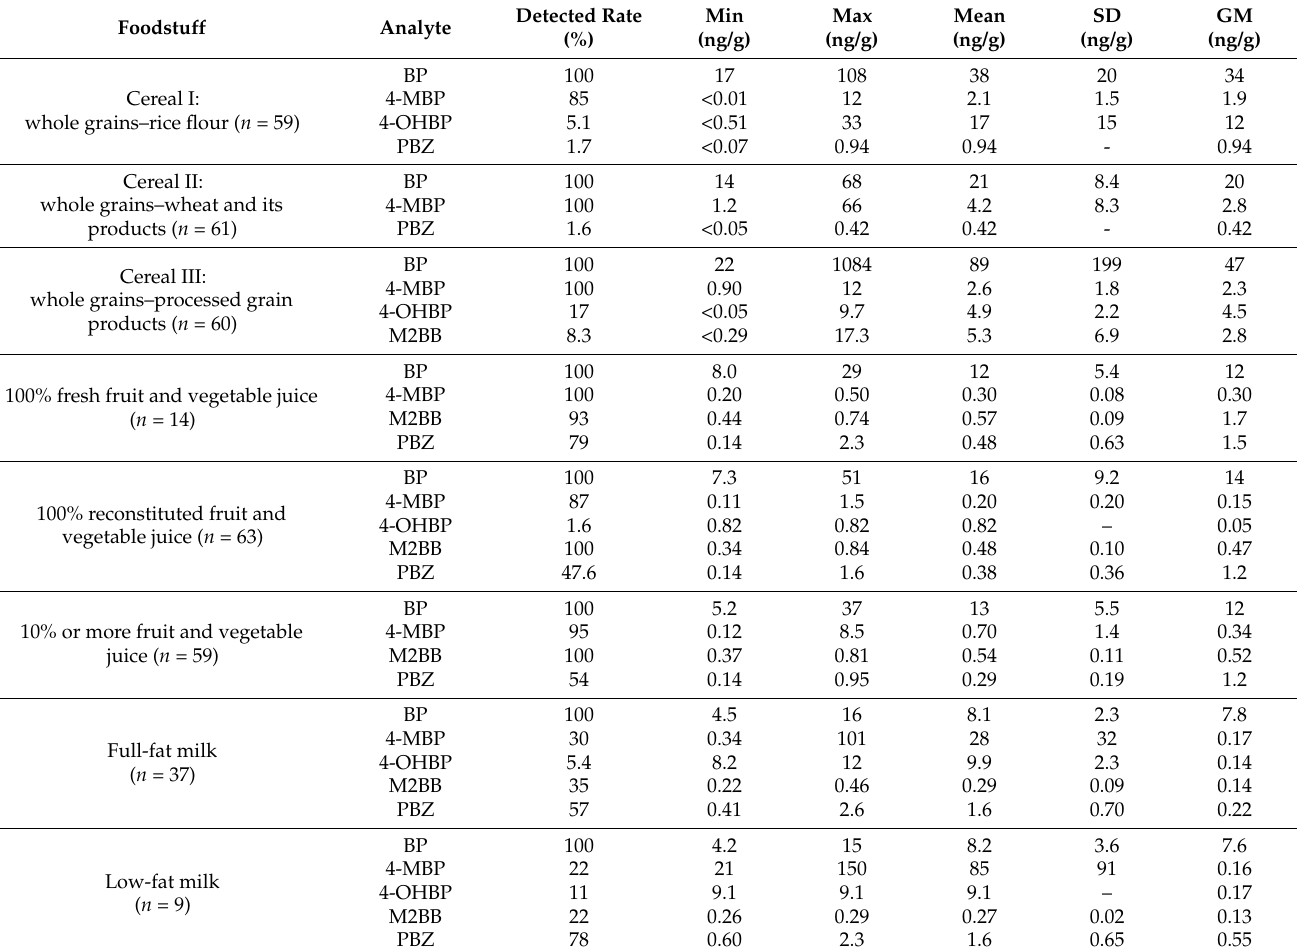
Table 1. Detection rates for printing ink or photoinitiators in a survey of 362 samples representing different food/packaging